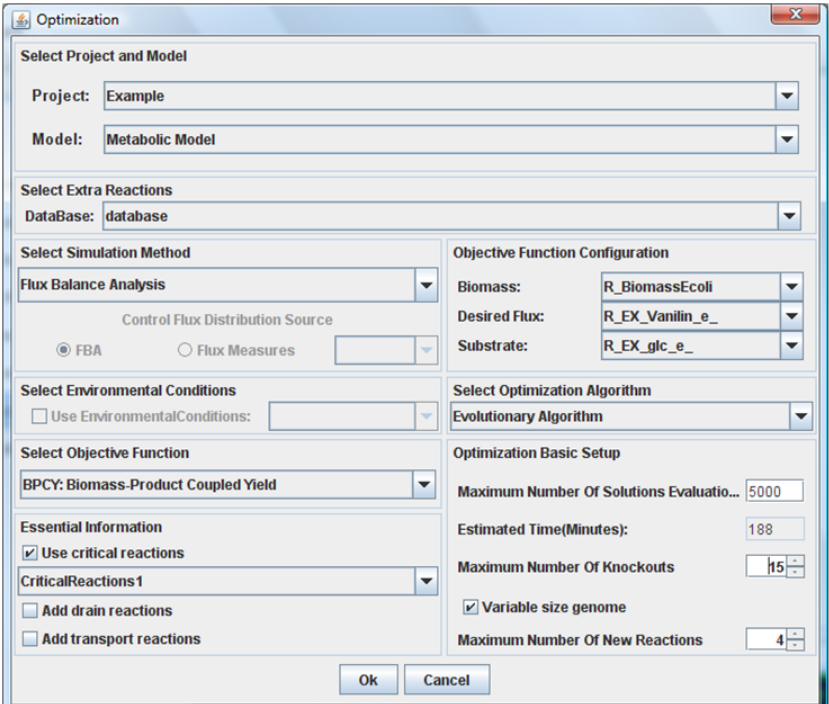
Figure 6: Interface for strain optimization processes. In this example, an EA is configured, the simulation method is FBA, the objective function is BPCY, essential information uses the critical reactions, a maximum of 15 knockouts and 4 new reactions are permitted in variable sized